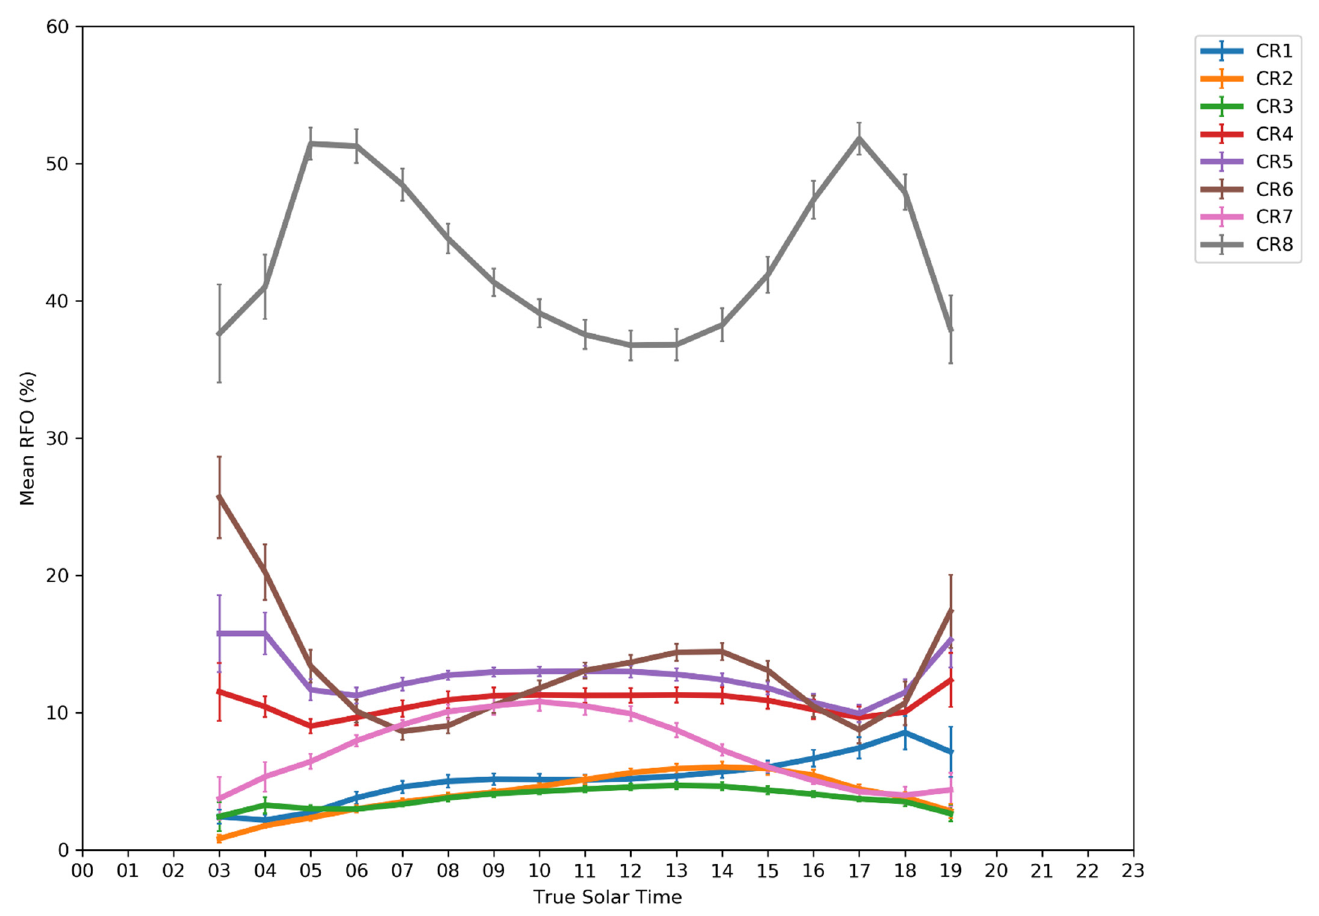
Figure 5. Mean diurnal variability of the relative frequency of occurrence (RFO) of the 8 CRAAS cloud regimes (CRs) over Europe for the 2004–2017 period.